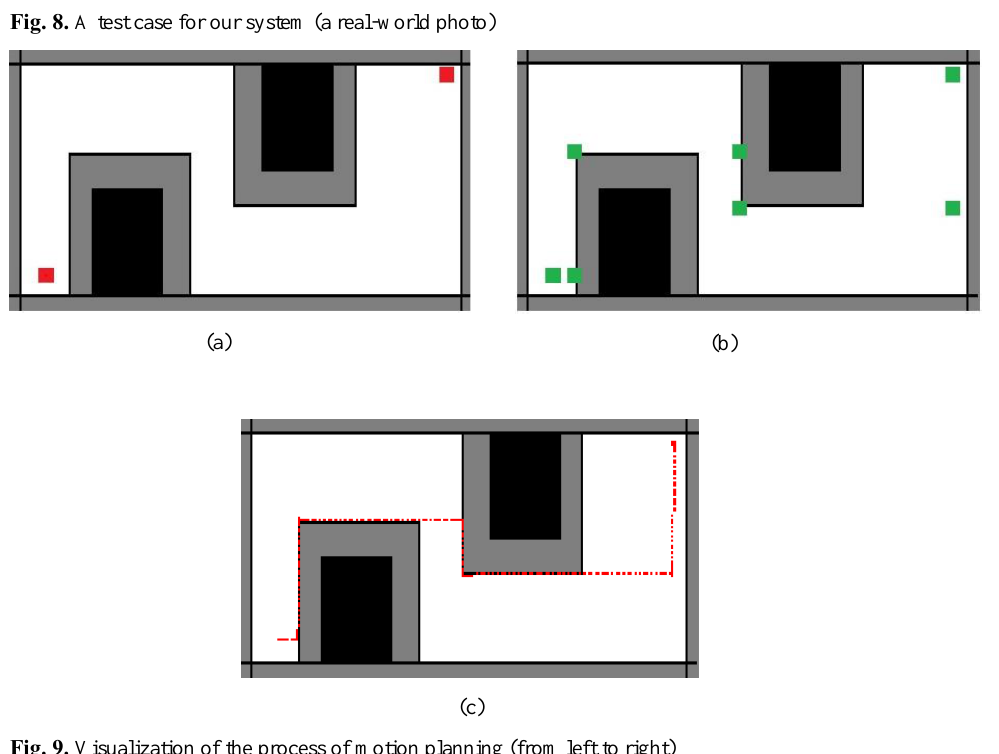
Fig. 9. Visualization of the process of motion planning (from left to right) (a) The interpreted map with obstacles in black, safety constraints in gray, and start and goal position in red (b) The critical points in green as the output of the global planner (theoretical path) (c) The real path drawn according to the received data from the odometry